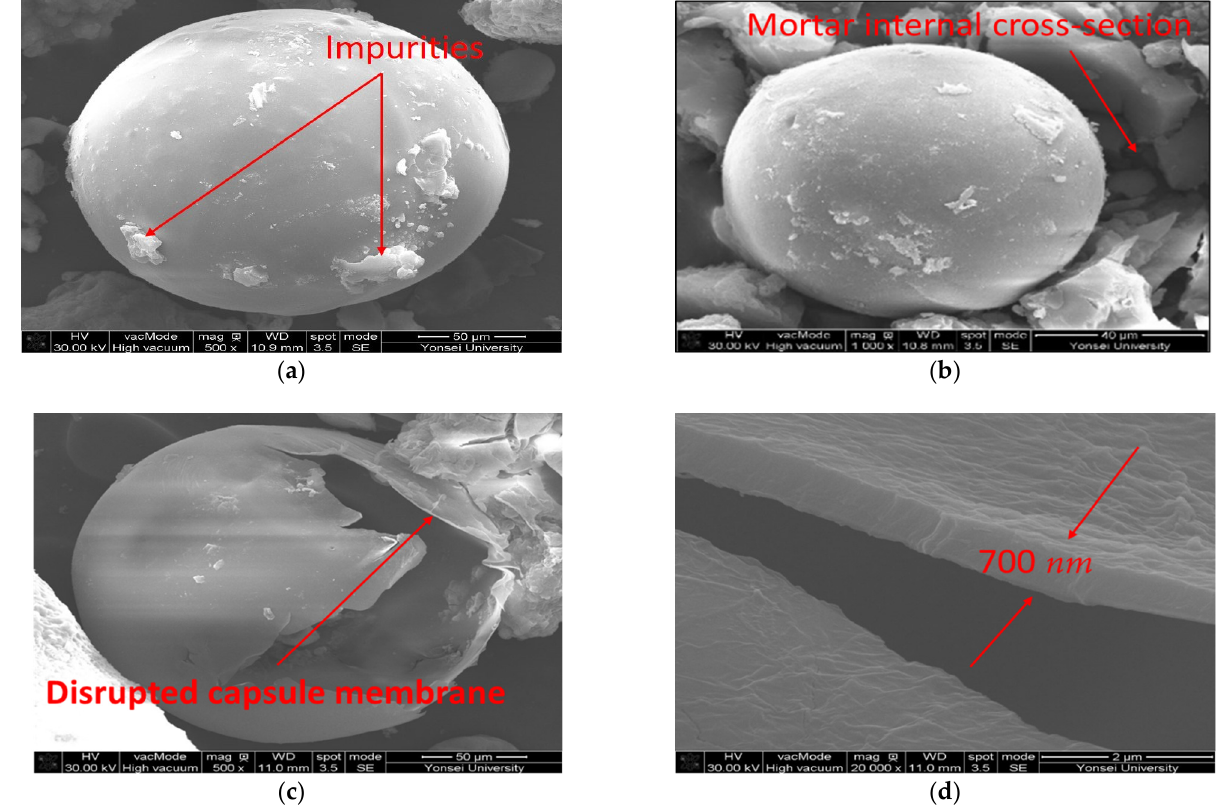
6 of 19 Figure 4. Manufacturing device of MCs: ( a ) drawing; ( b ) automatic manufacturing equipment; ( c ) emulsion agitator and chemical mixer; ( d ) vacuum cleaners, automatic pH controllers, and particle size controllers. 𝐴 ∗ (cid:2870) 𝑆𝑖𝑂 (cid:3397) xH (cid:2870) O (cid:3397) 𝐶𝑎(𝑂𝐻) (cid:2870) → 𝐶𝑎𝑆𝑖𝑂 (cid:2871) ∙ 𝑥𝐻 (cid:2870) 𝑂 (cid:3397) 2𝐴𝑂𝐻 𝐴 ∗ = alkali ions (K + , Na + , Li + ) (1) where, 𝐴 (cid:2870) 𝑆𝑖𝑂 (cid:2870) (cid:3397) xH (cid:2870) O : silicate minerals as core material in microcapsules 𝐶𝑎(𝑂𝐻) (cid:2870) : hydrates of cementitious materials 𝐶𝑎𝑆𝑖𝑂 (cid:2871) ∙ 𝑥𝐻 (cid:2870) 𝑂 : calcium silicate hydrate(C-S-H) 2𝐴𝑂𝐻 : alkali ions